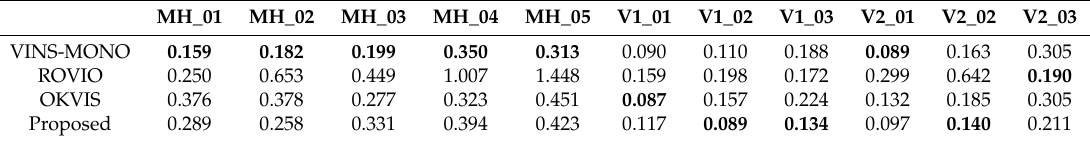
Table 4. Results of proposed and state-of-the-art VIOs using EuRoC dataset. Ten runs on each sequence and the means of positioning RMSEs (m) are